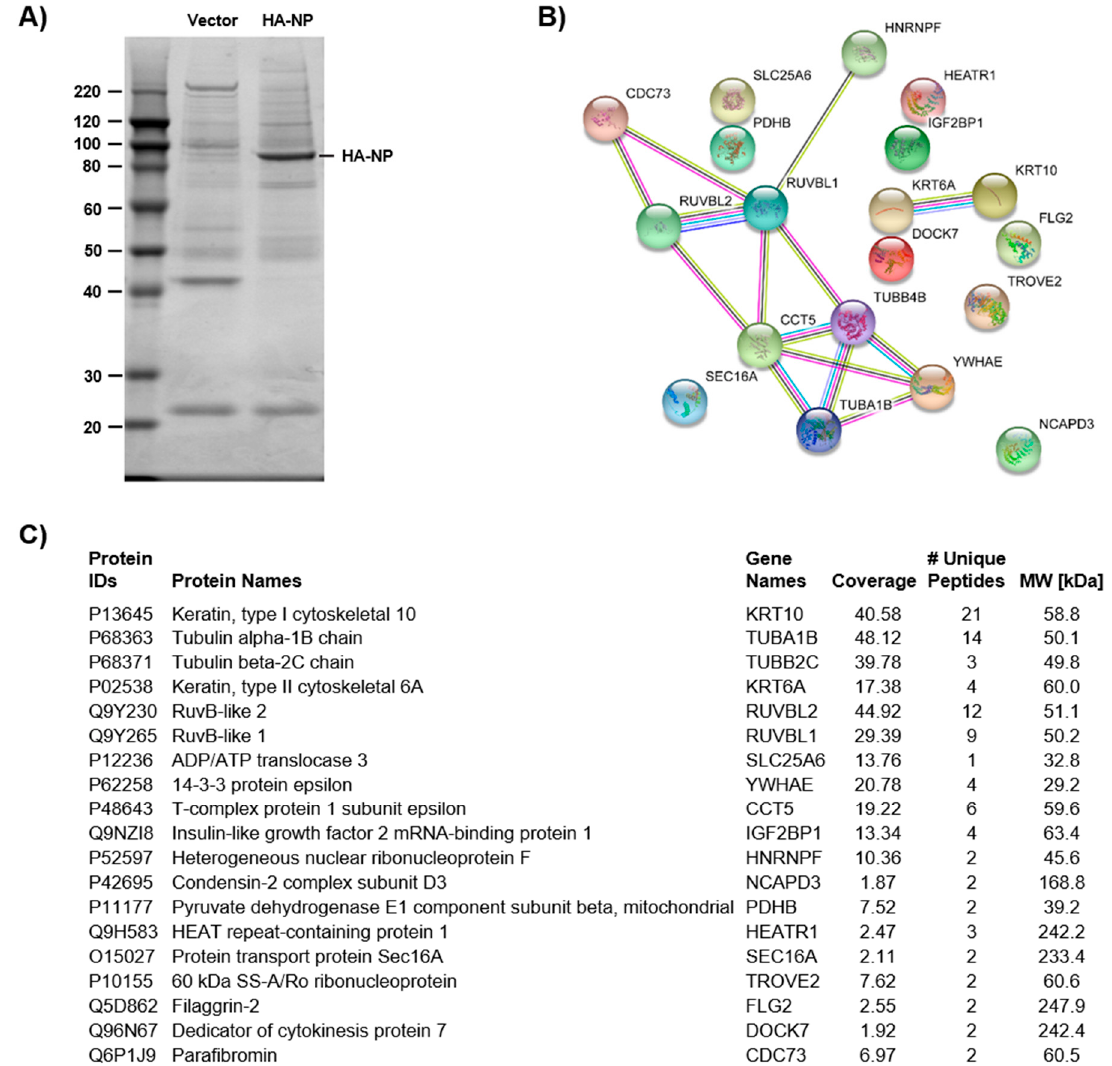
Figure 1. Identification of candidate Ebola virus (EBOV) nucleoprotein (NP)-interacting host proteins. ( A ) Silver stain of HA-NP immunoprecipitations. ( B ) STRING analysis of NP interactor candidates. ( C ) Candidate proteins identified by mass spectrometry analysis.